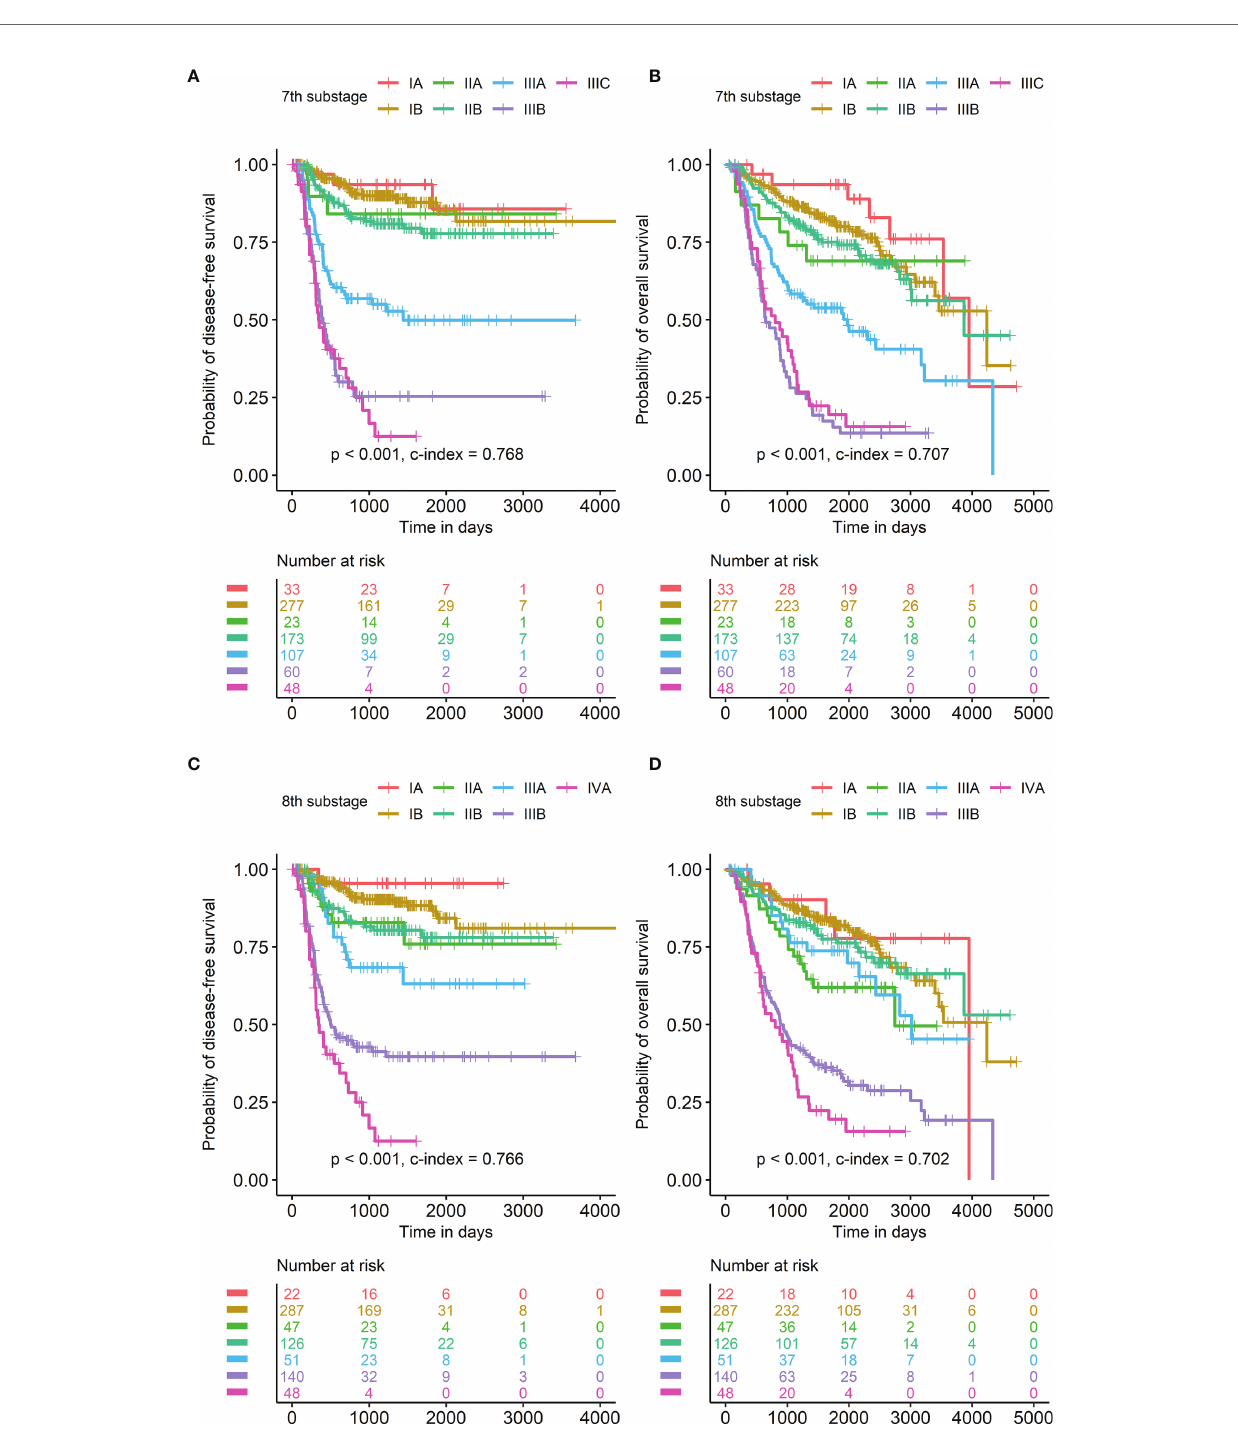
FIGURE 3 | Survival curves according to the AJCC/UICC staging systems Pathological substage based on the 7th edition of the AJCC/UICC staging system was a signi fi cant prognostic factor in both disease-free survival (A) and overall survival (B) . Pathological substage based on the 8th edition of the AJCC/UICC staging system was also a signi fi cant prognostic factor in both disease-free survival (C) and overall survival (D)